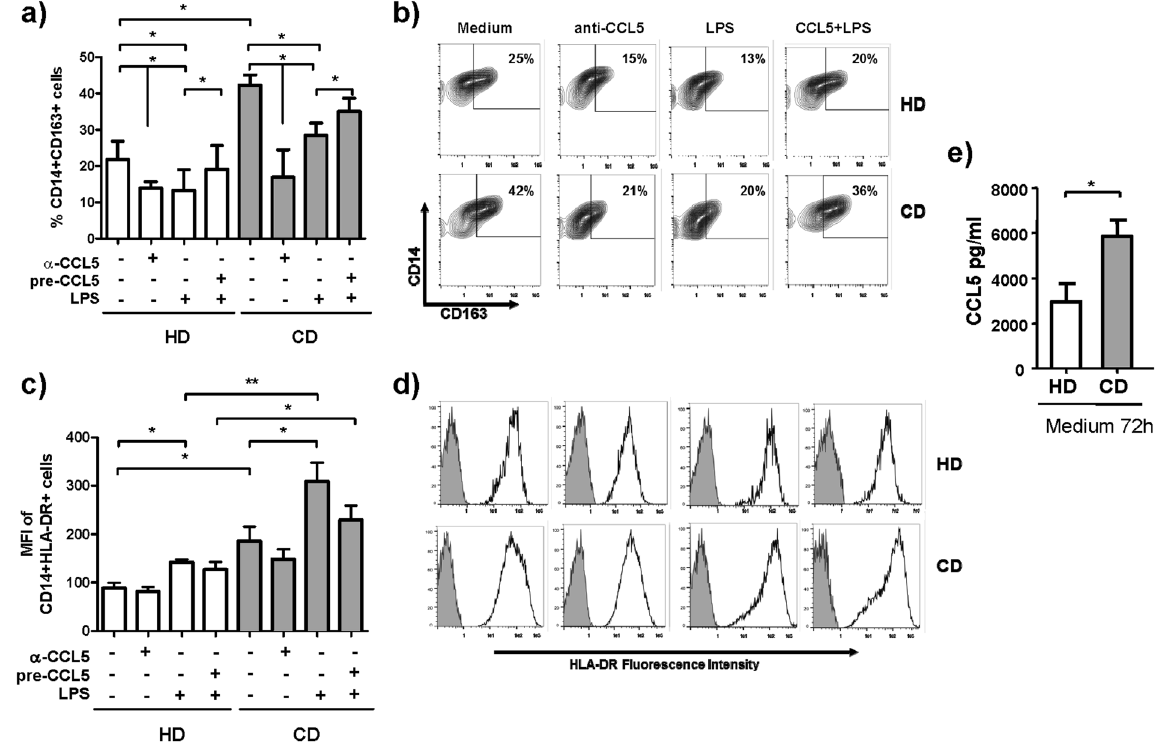
Figure 4. CCL5/CCR5 signaling modified the phenotype of monocytes during their maturation. ( a , c ) Peripheral blood monocytes from HD (n = 6) and CD patients (n = 7) were cultured with medium or with anti-CCL5 (10 ug/ml) for 72 h. Other peripheral blood monocytes from the same donors were cultured in medium for 24 h, then washed and stimulated for 24 h with or without CCL5 (10 ng/ml) (pre-CCL5). These cells were then washed and stimulated for 24 h with LPS (10 ng/ml). At the end of the cultures, cells were washed and stained with anti-CD14, anti-CD163, and anti-HLA-DR and were analyzed by flow cytometry. Results are expressed as the percentage of CD14 + CD163 + cells and the mean fluorescence intensity (MFI) of CD14 + HLA-DR + cells. ( b , d ) A representative experiment of the CD163 and HLA-DR expression on peripheral blood monocytes after 72 h of culture with each described condition. Dot plot shows the percentage of CD14 + and CD163 + from HD and inactive CD patients. Histogram shows the expression of HLA-DR on gated CD14 + monocytes from HD and CD patients (gray shaded histogram: isotype control, unshaded histogram: anti-HLA-DR antibodies). ( e ) CCL5 concentration in the supernatants of peripheral blood monocytes from HD and CD patients after 72 h in medium was quantified by ELISA. Multiple comparisons were calculated by ANOVA (% of CD163 + monocytes in HD: p = 0.19 and in CD: p = 0.01; MFI of HLA-DR in HD: p = 0.40 and in CD: p = 0.09). Mann-Whitney U test was used for comparisons between HD and CD patients. Wilcoxon test was used for the comparisons between medium and each condition in HD and CD patients ( * p < 0.05, ** p <